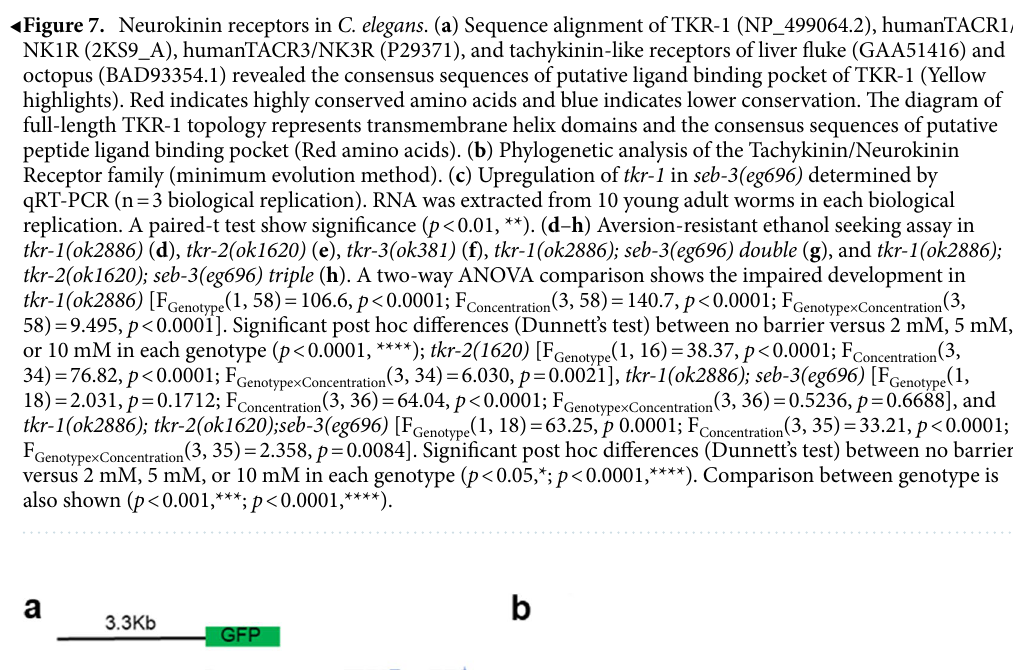
Figure 7. Neurokinin receptors in C. elegans . ( a ) Sequence alignment of TKR-1 (NP_499064.2), humanTACR1/ NK1R (2KS9_A), humanTACR3/NK3R (P29371), and tachykinin-like receptors of liver fluke (GAA51416) and octopus (BAD93354.1) revealed the consensus sequences of putative ligand binding pocket of TKR-1 (Yellow highlights). Red indicates highly conserved amino acids and blue indicates lower conservation. The diagram of full-length TKR-1 topology represents transmembrane helix domains and the consensus sequences of putative peptide ligand binding pocket (Red amino acids). ( b ) Phylogenetic analysis of the Tachykinin/Neurokinin Receptor family (minimum evolution method). ( c ) Upregulation of tkr-1 in seb-3(eg696) determined by qRT-PCR (n = 3 biological replication). RNA was extracted from 10 young adult worms in each biological replication. A paired-t test show significance ( p < 0.01, **). ( d – h ) Aversion-resistant ethanol seeking assay in tkr-1(ok2886) ( d ), tkr-2(ok1620) ( e ), tkr-3(ok381) ( f ), tkr-1(ok2886); seb-3(eg696) double ( g ), and tkr-1(ok2886); tkr-2(ok1620); seb-3(eg696) triple ( h ). A two-way ANOVA comparison shows the impaired development in tkr-1(ok2886) [F Genotype (1, 58) = 106.6, p < 0.0001; F Concentration (3, 58) = 140.7, p < 0.0001; F Genotype×Concentration (3, 58) = 9.495, p < 0.0001]. Significant post hoc differences (Dunnett’s test) between no barrier versus 2 mM, 5 mM,